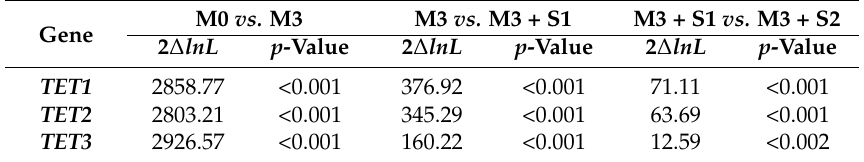
Table 2. Likelihood ratio tests (LRTs) between different model comparisons in the Fitmodel program. M0 vs. M3 Gene